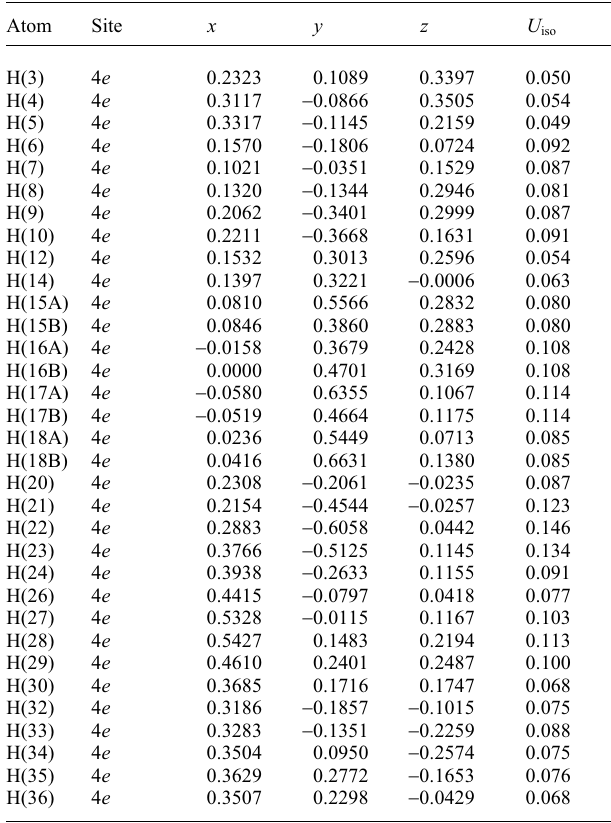
Table 2. Atomic coordinates and displacement parameters (in Å 2 )